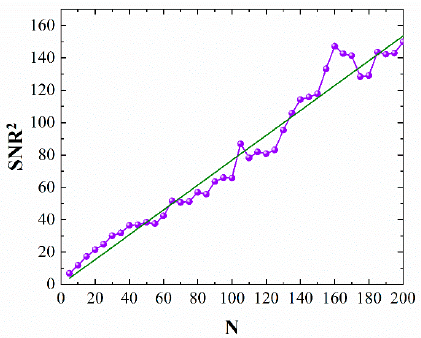
Figure 4. The experimental results of signal-to-noise ratio (SNR) 2 under different periods by using the method of signal classification and